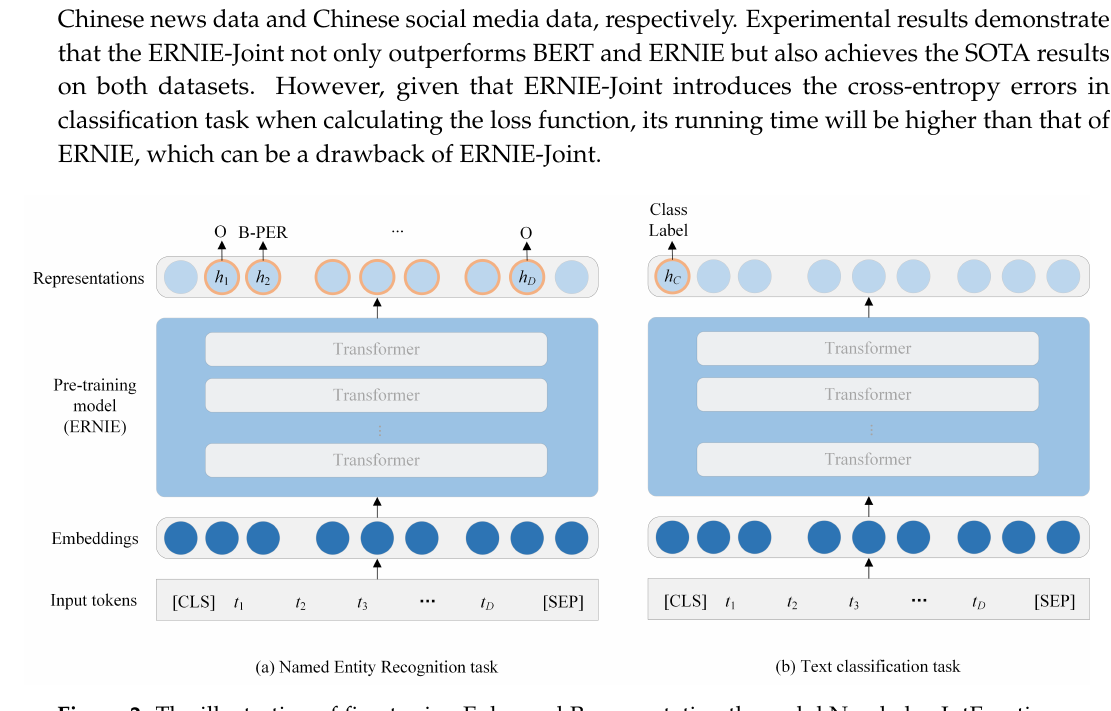
Figure 2. The illustration of fine-tuning Enhanced Representation through kNowledge IntEgration (ERNIE) on Named Entity Recognition (NER) and text classification